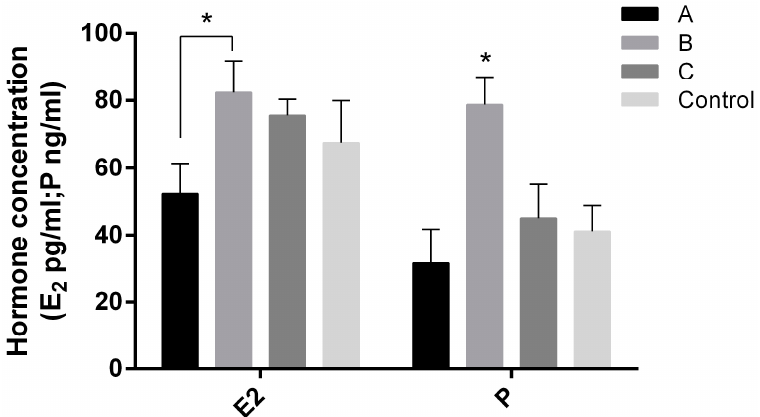
Figure 5. E 2 and P concentrations in serum of Day 7.5 pregnant mice treated with or without melatonin (4.3 μ g/mL) in drinking water. A, melatonin was given 14 days before mating (vaginal plugs was detected); B, melatonin was given from the mating to the delivery; C, melatonin was given from 14 days before mating to the delivery; Control: without melatonin. n = 10. “*” represents a significant difference of these columns ( p < 0.05).